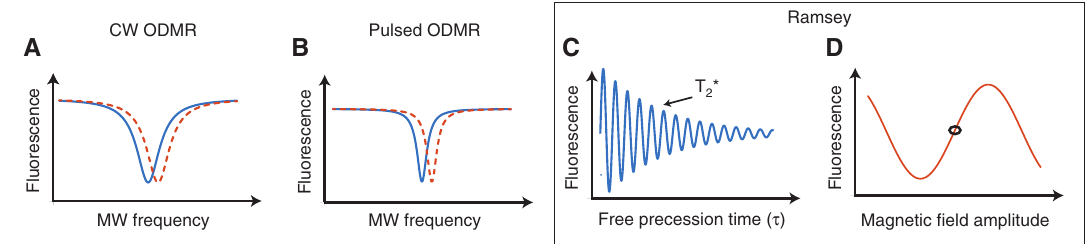
Figure 6: DC magnetometry protocols. (A) Example CW ODMR lineshape before (blue) and after (red) change in magnetic field. (B) Example pulsed ODMR lineshape before (blue) and after (red) change in magnetic field. (C) Schematic Ramsey free induction decay (FID) to determine the dephasing time ∗ optimal sensing time ( τ ). (D) Schematic Ramsey magnetometry curve. Free precession time is fixed to be the point of maximum slope sense , T indicated by a black circle. Accumulated phase from the sample field results in an oscillatory response of of the FID curve closest to ∗ 2 fluorescence with changing